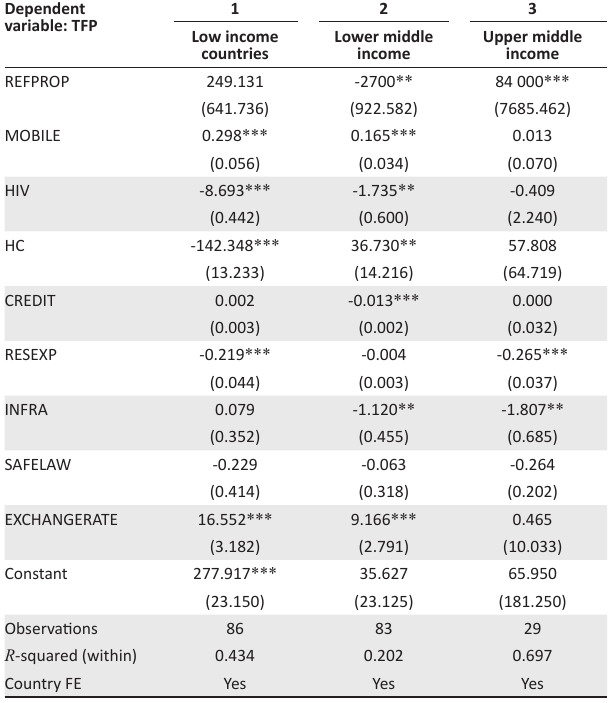
TABLE 6: Low income, lower middle and upper